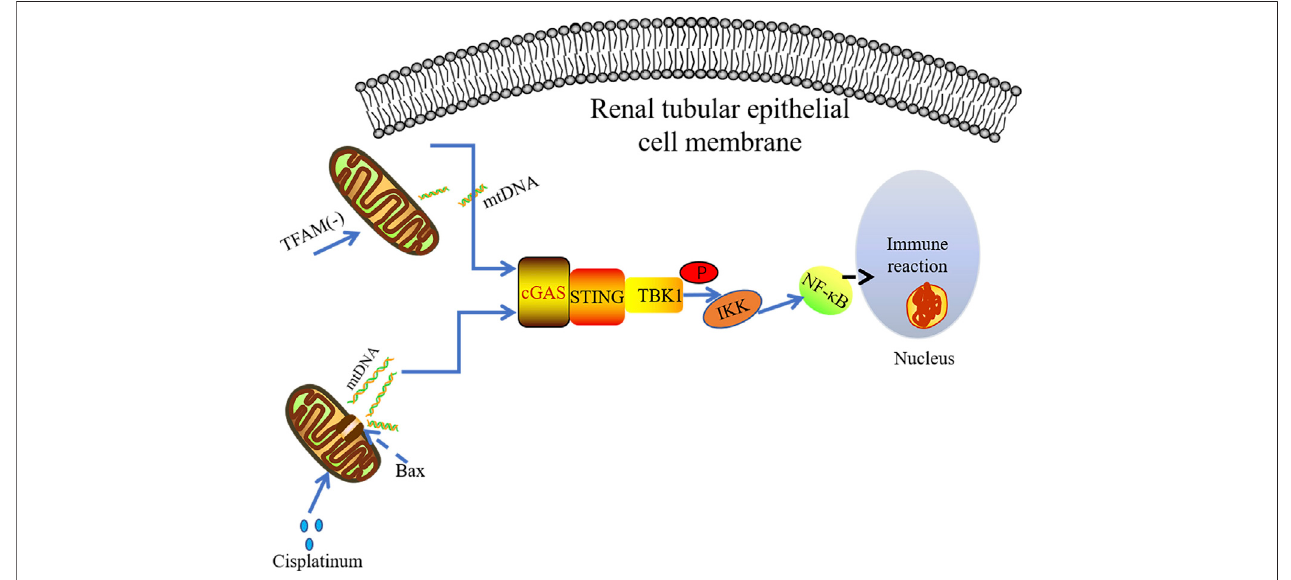
FIGURE 4 | mtDNA leakage plays a key role in cisplatin-induced kidney in fl ammation. The damaged mitochondria can result in cGAS-STINF-NF-kB pathway activationintherenaltubules.TheabsenceofTFAMleadstomitochondrialdamageandthereleaseofmtDNA,whichmainlyactivatesthecGAS-STING-NF- κ Bpathway to induce in fl ammatory